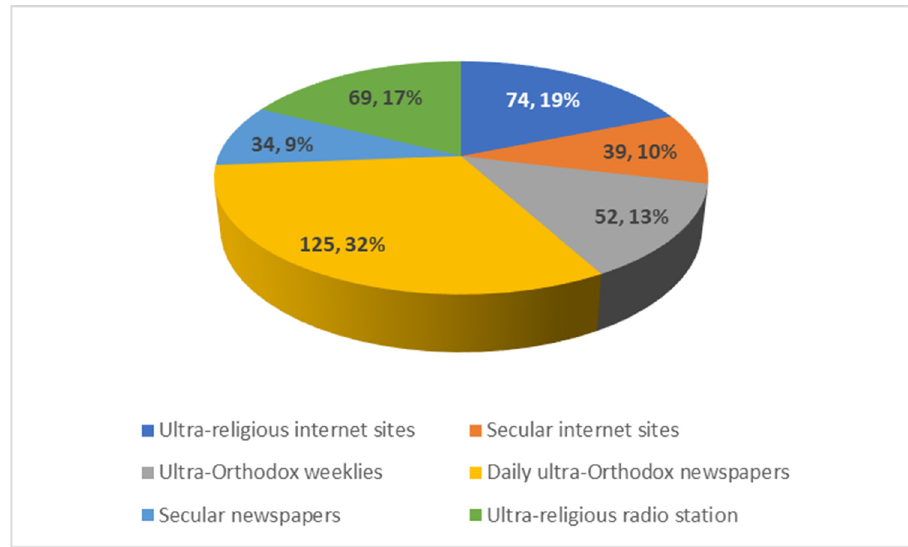
Figure 3. Number and percentage of communication types used to access information on COVID-19 (N = 393).